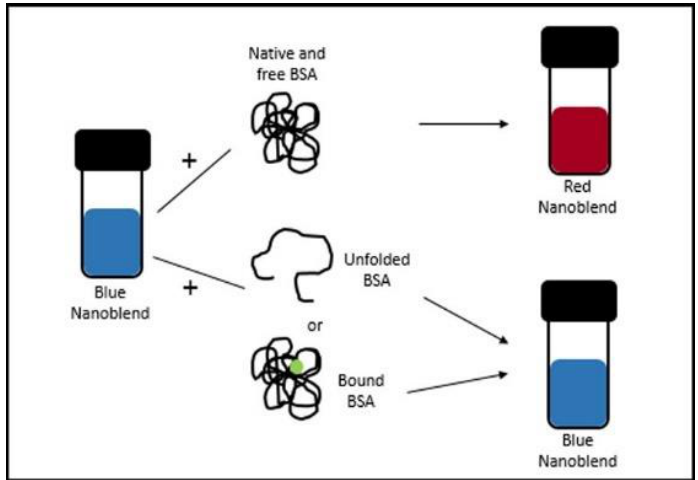
Figure 1. Colorimetric response of the L64 nanosensor to the different forms of BSA proteins. Reprinted/adapted with permission from Ref. [18].